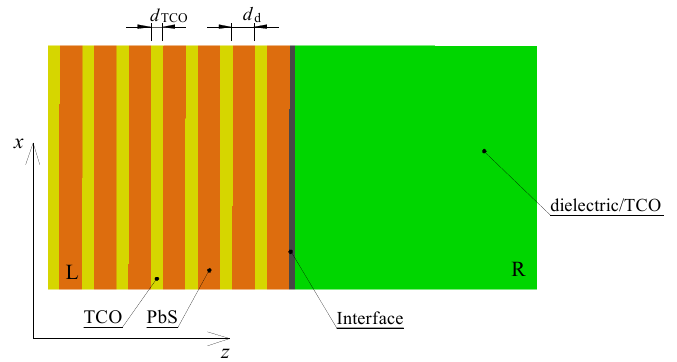
Figure 11. Interface of multilayered MM made of periodically changing transparent-conducting oxide (TCO) and dielectric layers. The MM/dielectric ( ε R = 1 or ε R = 2.25) and MM/TCO boundaries are investigated.